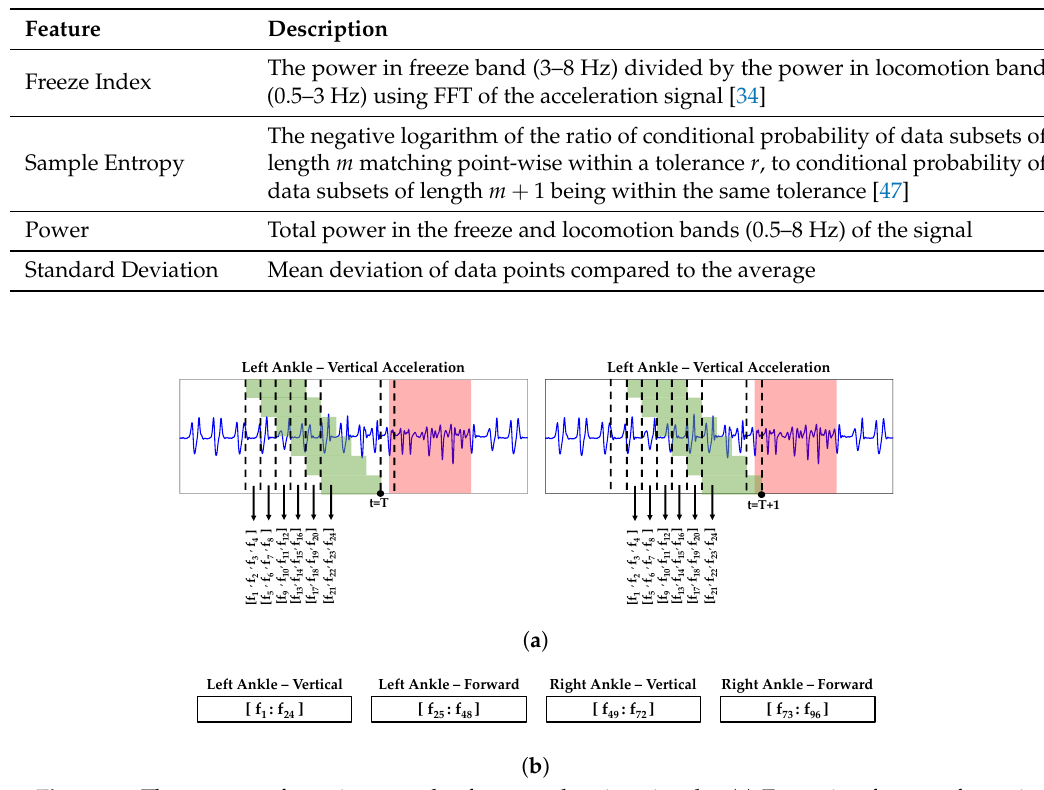
Table 1. Set of features extracted from each window of data.